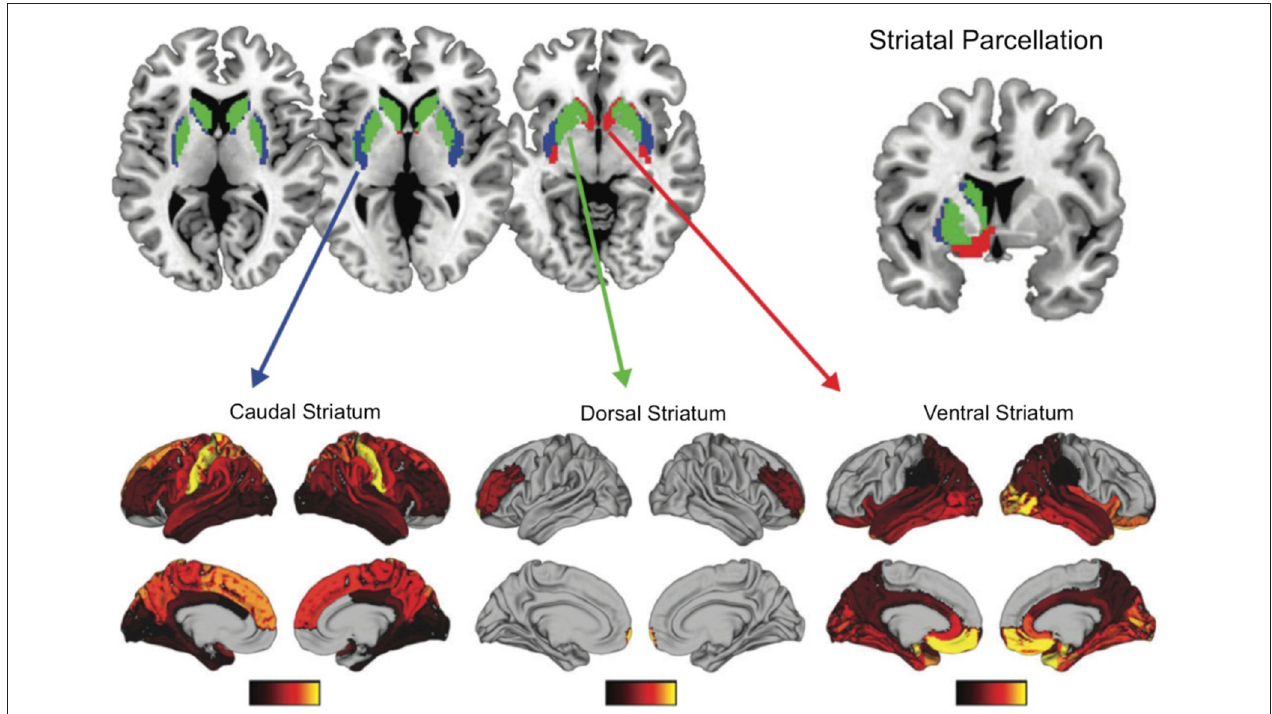
FIGURE 6 | Functional connectivity patterns of three striatal subregions with the rest of the brain. Transcriptional signatures in these subregions is a good predictor of these functional connectivity patterns, with dopamine being an important genetic marker for ventral and dorsal striatum functionally connectivity with limbic regions and LPFC respectively. Figure adapted with permission from Parkes et al.